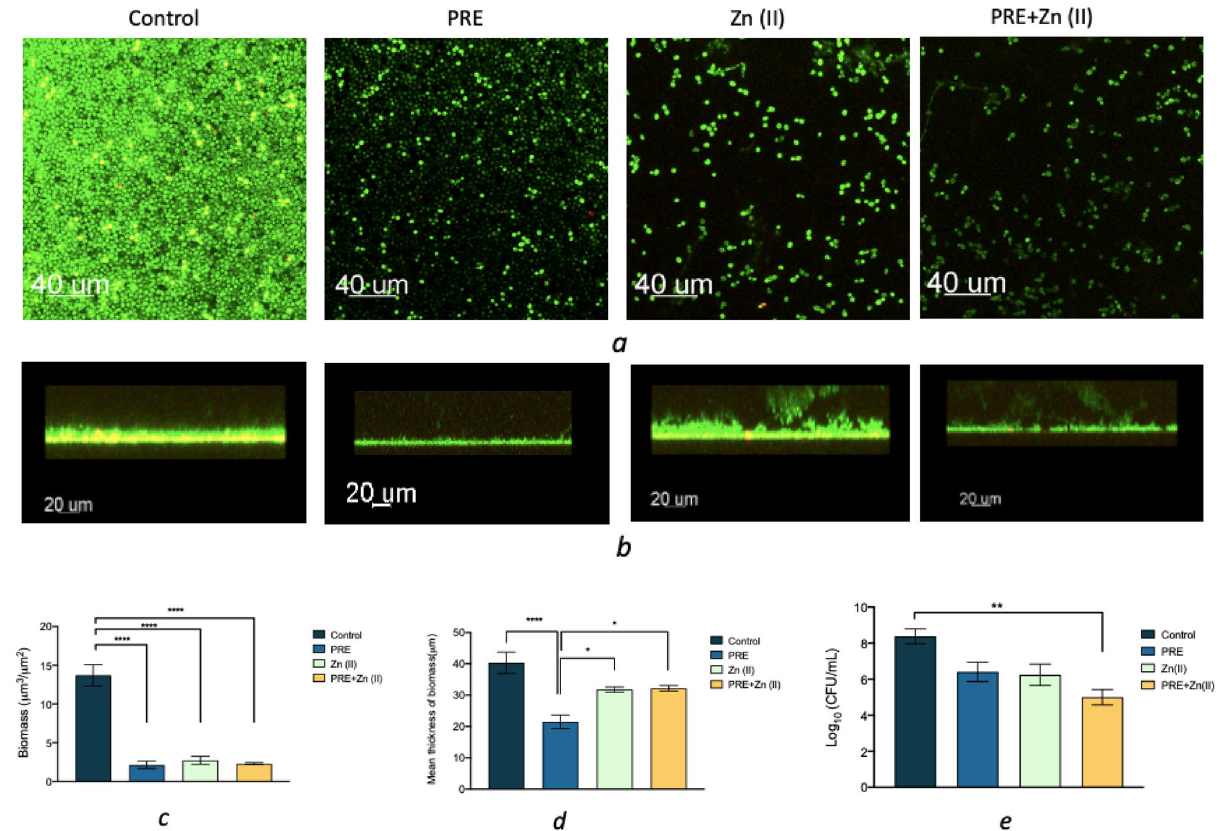
Figure 3. ( a and b ) CLSM images of C. albicans biofilm after incubation with PRE (4 mg/mL), Zn (II) (1.8 mg/ mL) and PRE and Zn (II) combined (4 mg/mL + 1.8 mg/mL), at 37 °C for 24 h. ( c and d ) Comparison of different variables of C. albicans biofilm using CLSM/COMSTAT2 analysis. ( e ) Log 10 values of C. albicans biofilm a after incubation with PRE, Zn (II) and PRE and Zn (II) combined, at 37 °C for 24 h. Significance indicated by *, where *p < 0.05, **p < 0.01, ***p < 0.001, and ****p < 0.0001 . Data represented as mean ± SEM (n =